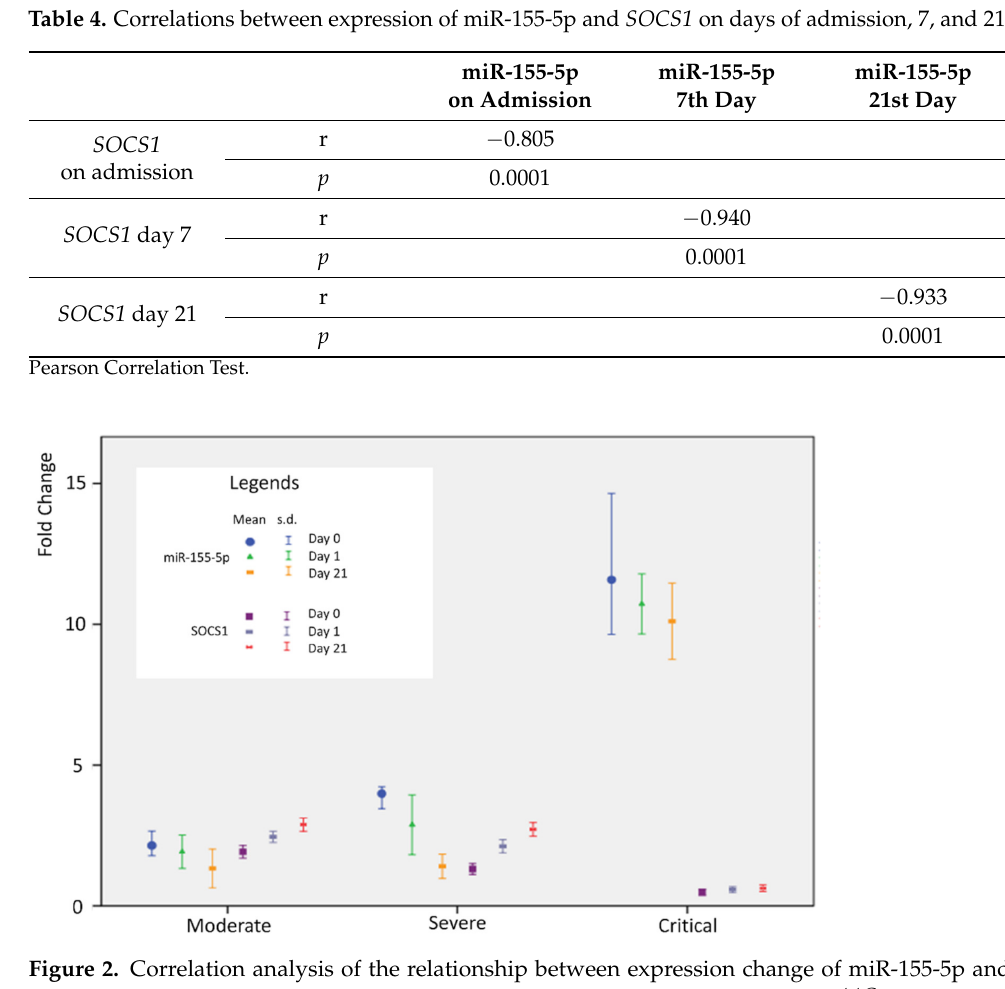
Figure 2. Correlation analysis of the relationship between expression change of miR-155-5p and SOCS1 variables on admission, day 7, and day 21. Figure shows the relation of the 2 − ∆∆ Ct -transformed quantification of the variables and difference expressions and severity of